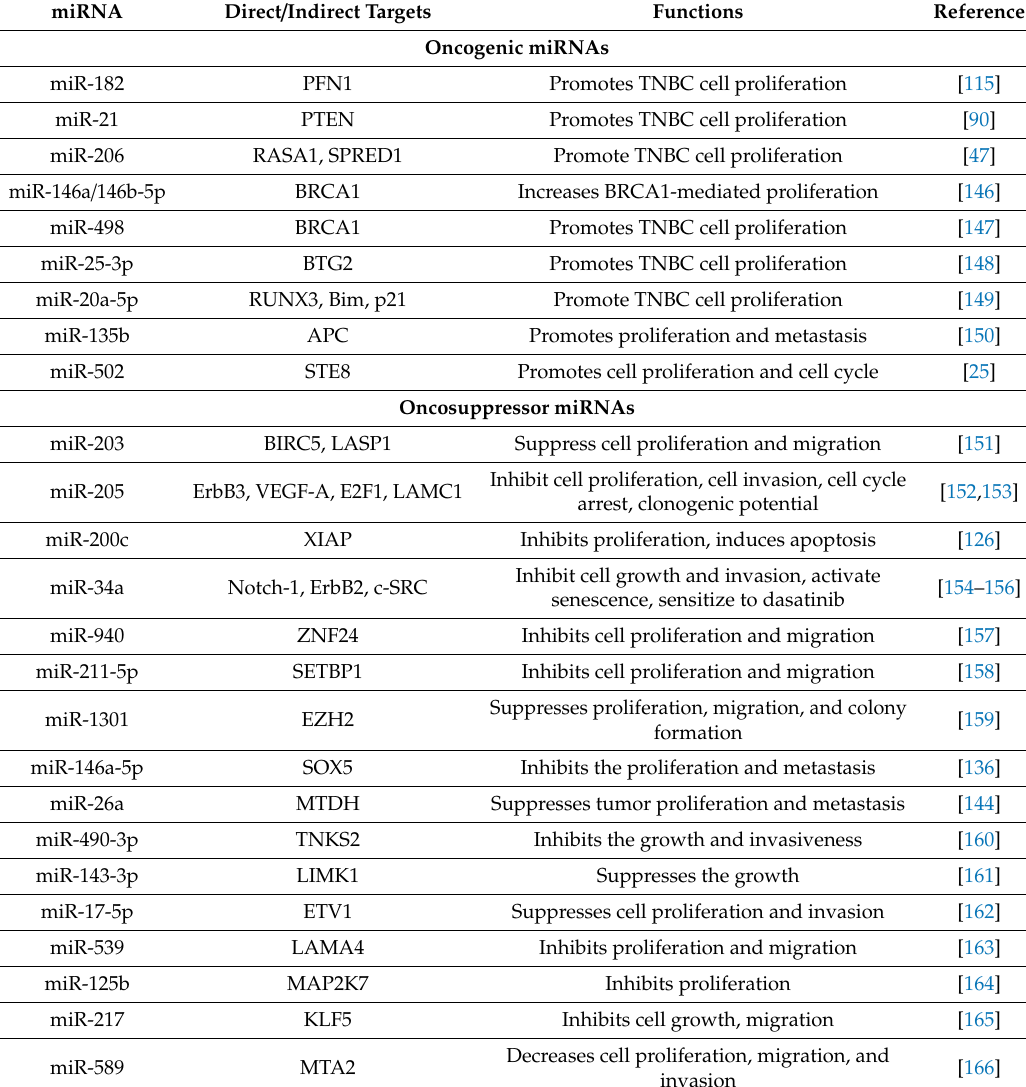
Table 6. MiRNAs associated with proliferation in